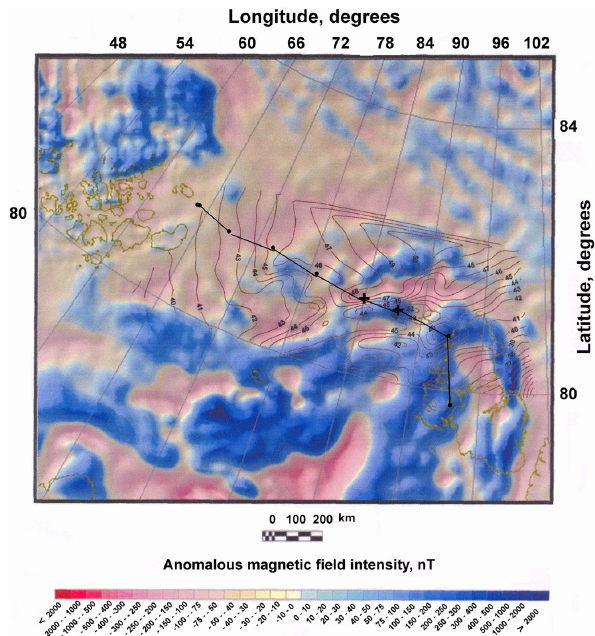
Figure 9. Chart of anomalies in the modulus of geomagnetic field strength for the high-latitude part of the airship flight route with isogonic lines of magnetic declination. The crosses mark the points of determination of D during the